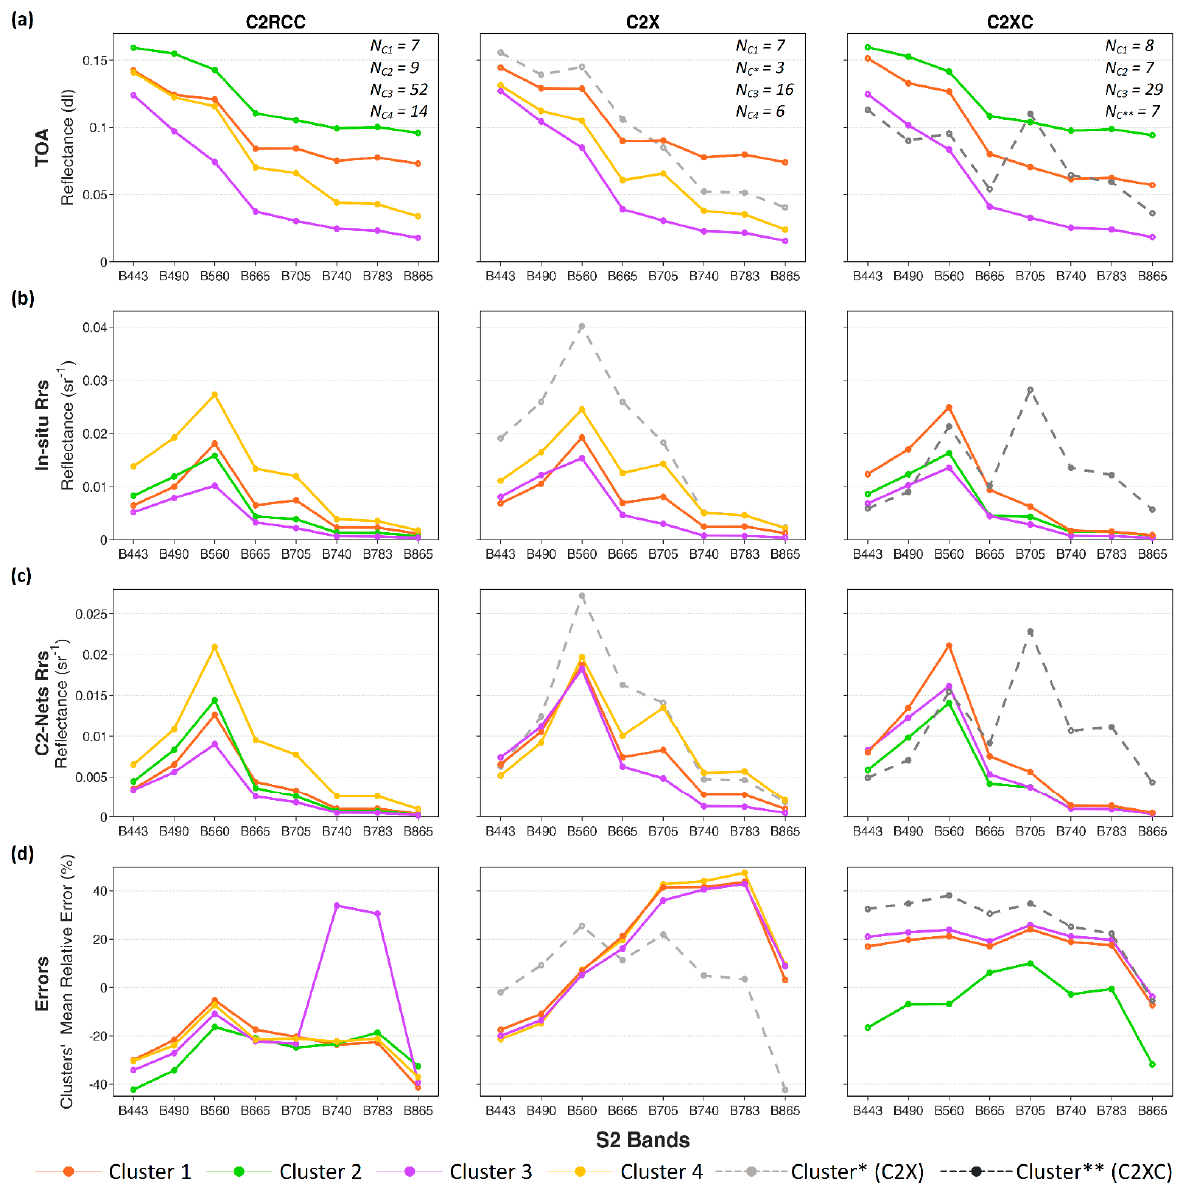
Figure 8. K-means clustering including TOA reflectance and measured and C2-Nets-derived Rrs ( a – c ). Lines represent, by C2-Net (columns), cluster centers for ( a ) TOA reflectance, ( b ) in situ Rrs, ( c ) C2-Nets Rrs, and ( d ) mean relative error of cluster members’ in situ and C2-Nets Rrs. For ease of representation, clusters are colored according to the similarity between C2-Nets classes.